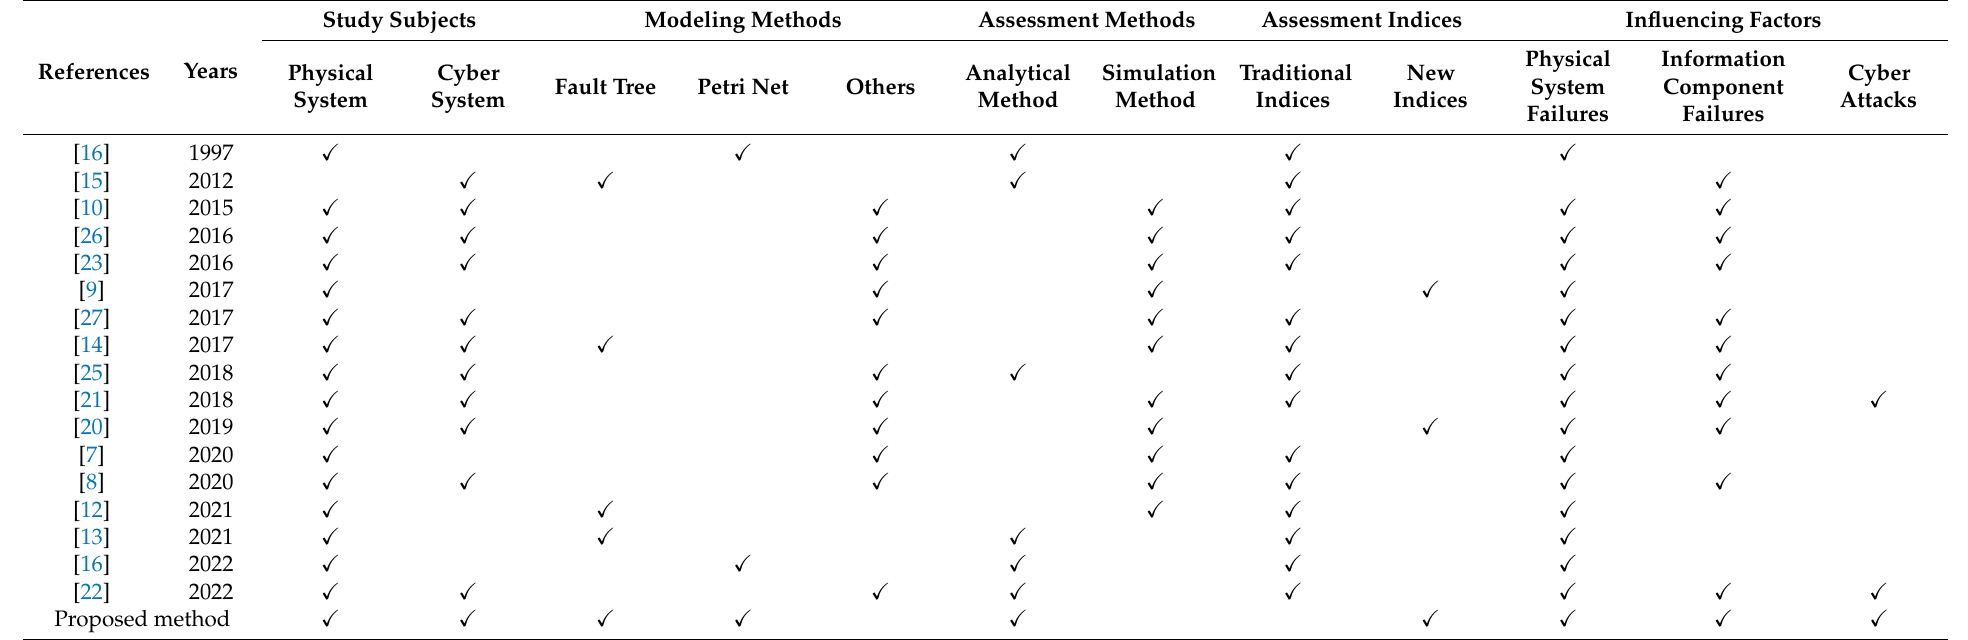
Table 1. Comparative literature review of reliability assessment in distribution network